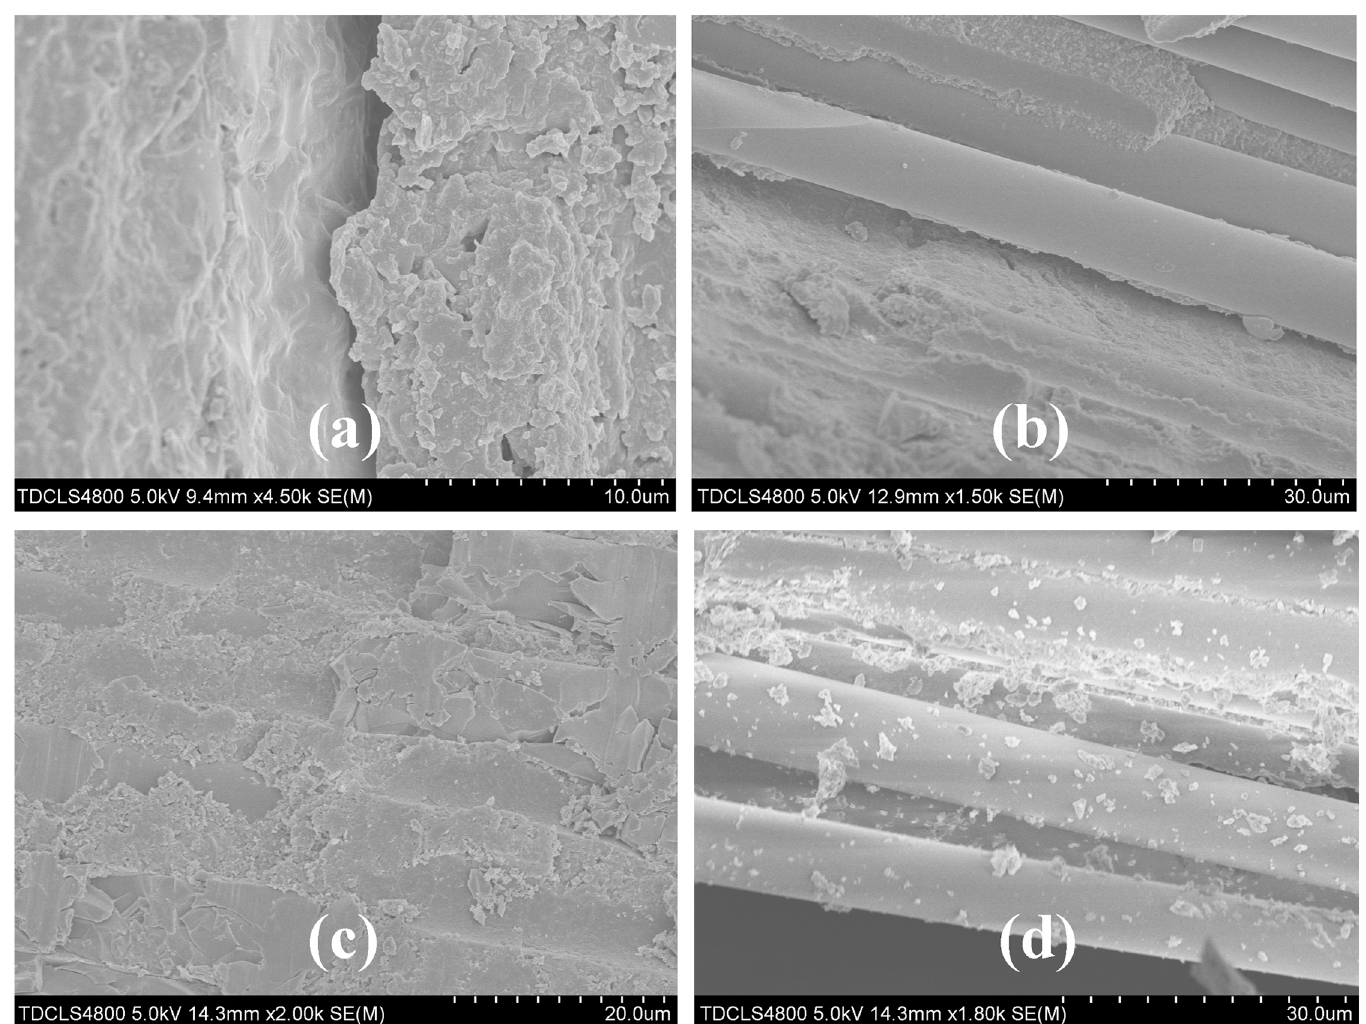
Fig 4. SEM images of the adhesive interface after push-out test. (a) A: zirconia post, B: resin cement. (b) A: fiber post, B: resin